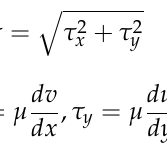
Figure 12. Schematic diagram of different sections.